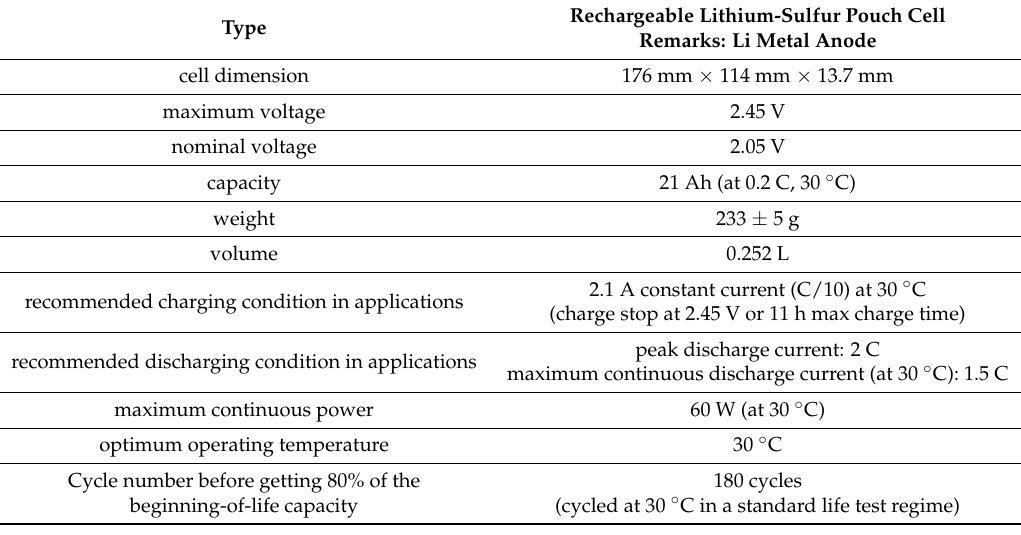
Table 1. Specifications of a prototype Li-S cell manufactured by OXIS Energy